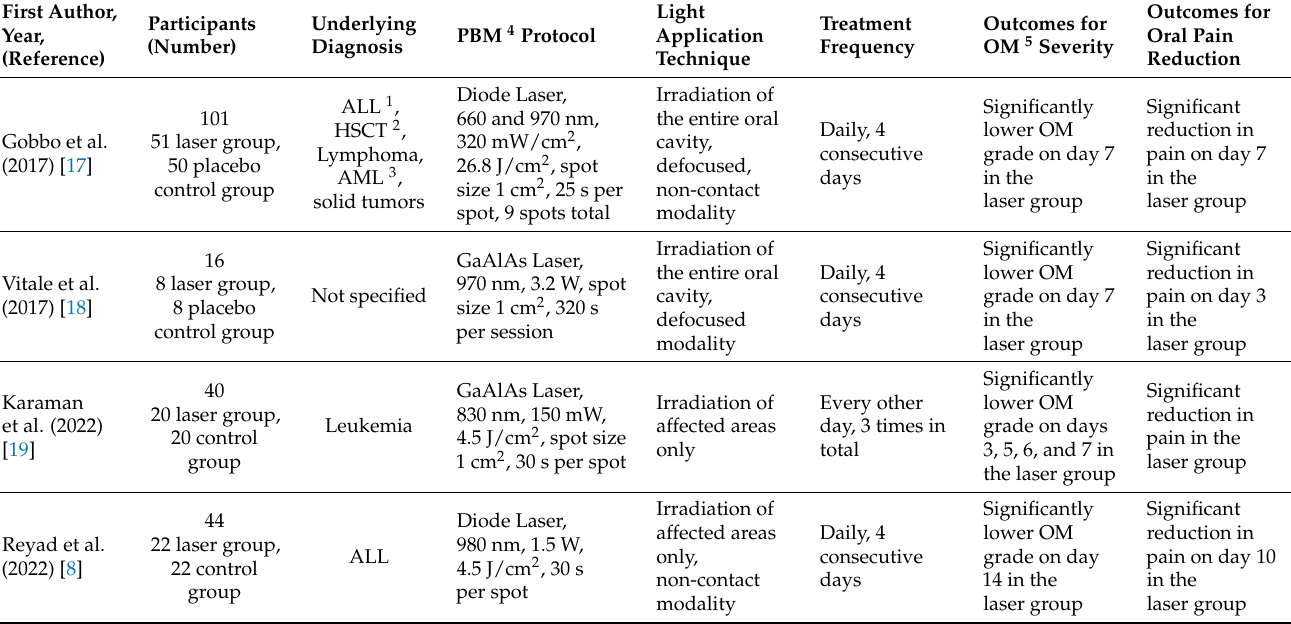
Table 1. Studies addressing PBM treatment of chemotherapy-induced OM in children compared to placebo or no